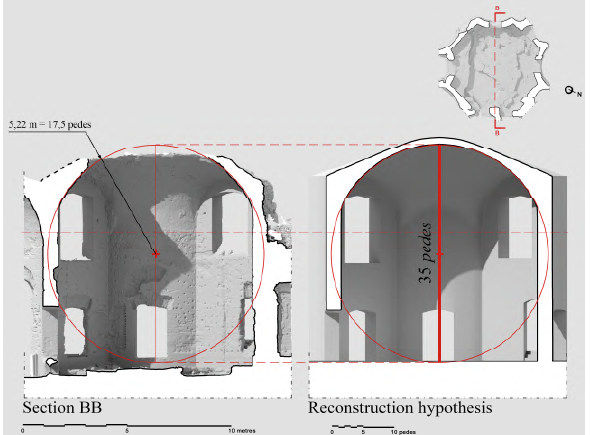
Figure 11. Best-fitting circle extracted from the intrados.